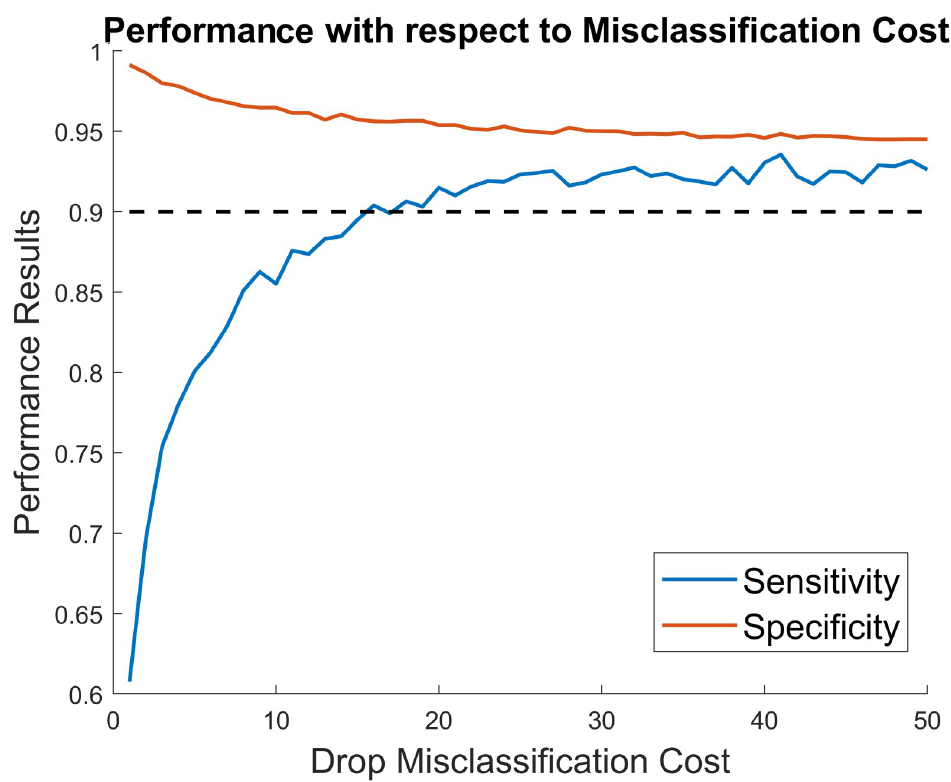
Fig 7. Effect of drop misclassification cost on performance results. Changes in sensitivity and specificity when the drop misclassification cost is increased is shown in blue and red respectively. The black dashed line indicates the cut- off level of 0.9 which was deemed acceptable for both